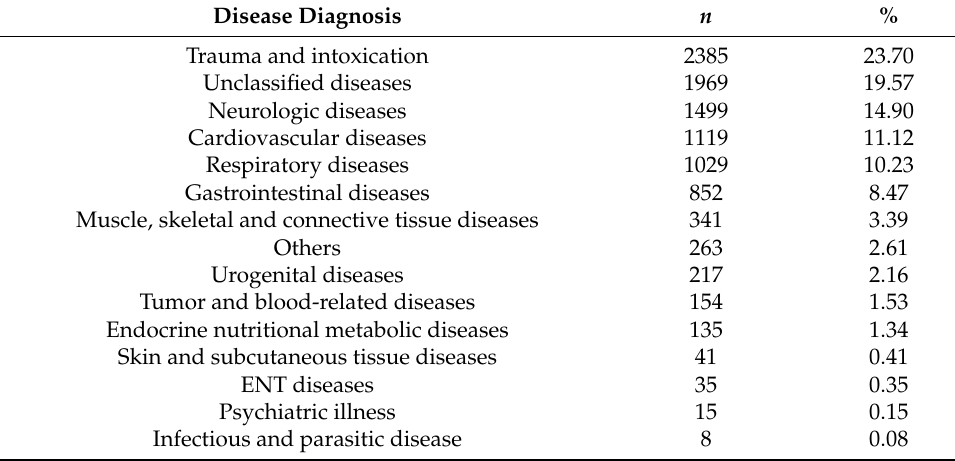
Table 3. Ambulance crew diagnosis regarding elderly patients.